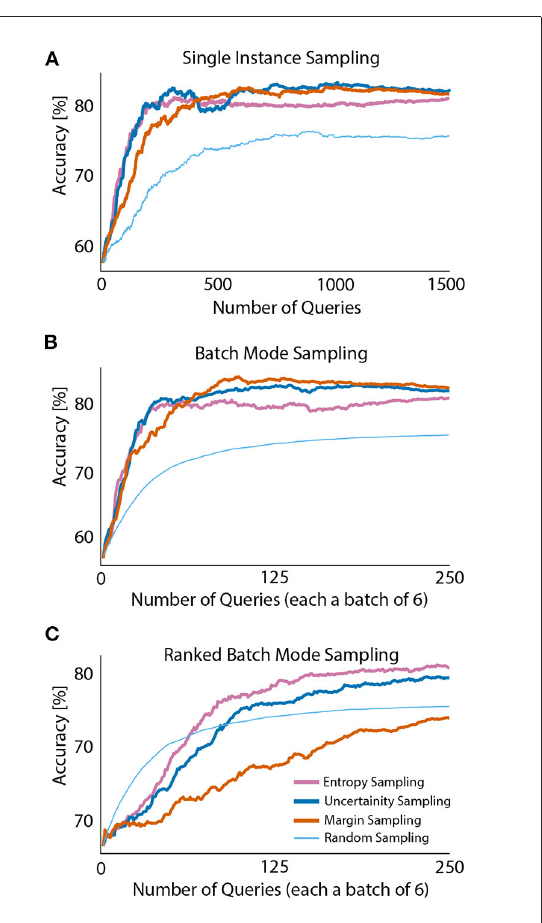
FIGURE5 Comparison of single instance (A) , batch mode (B) and ranked batch mode (C) sampling methods in one representative